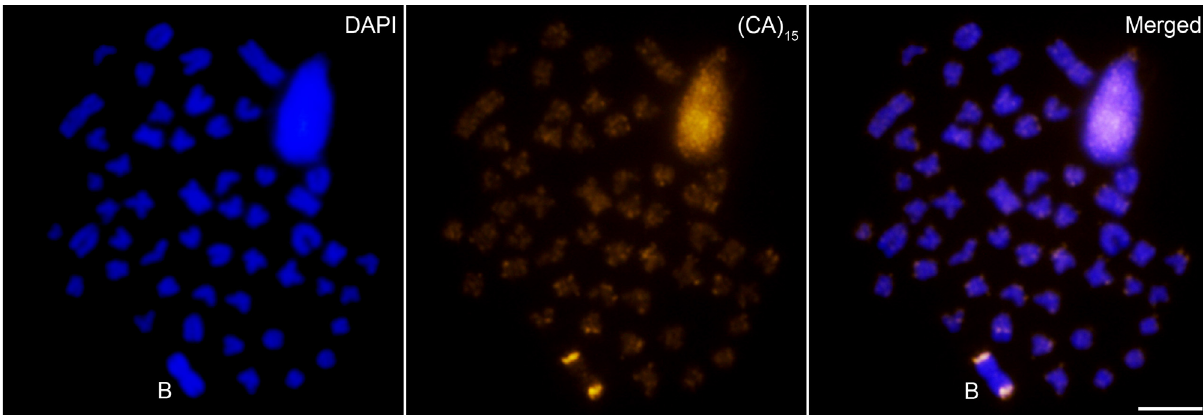
probe. Chromosomes were counterstained with DAPI. Bar = 10 15